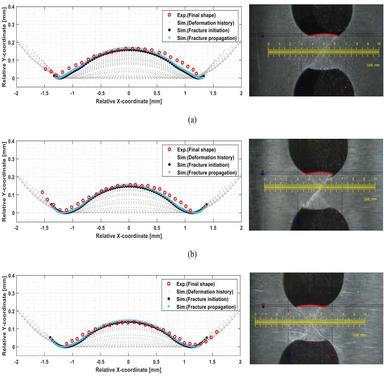
Barreling shape of the fractured specimen with (a) no pre-tensile strain, (b) pre-tensile strain of 0.079, and (c) pre-tensile strain of 0.093.